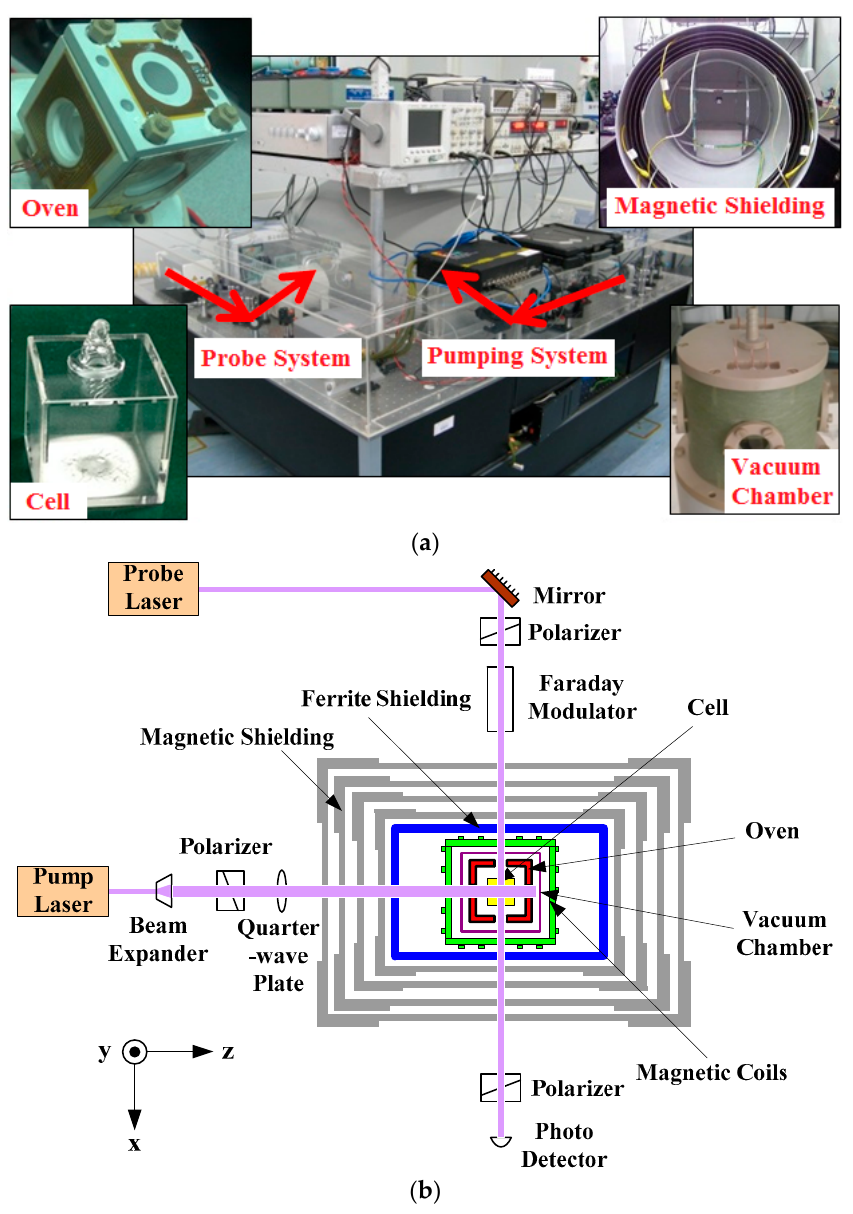
Figure 2. Arrangement of the SERF atomic spin magnetometer. ( a ) The photograph of the experimental device; ( b ) The schematic diagram of the light path. The pump beam propagates along the z direction. The probe beam is perpendicular to the pump beam and propagates along the x direction. The ferrite shielding is used to reduce the magnetic noise.